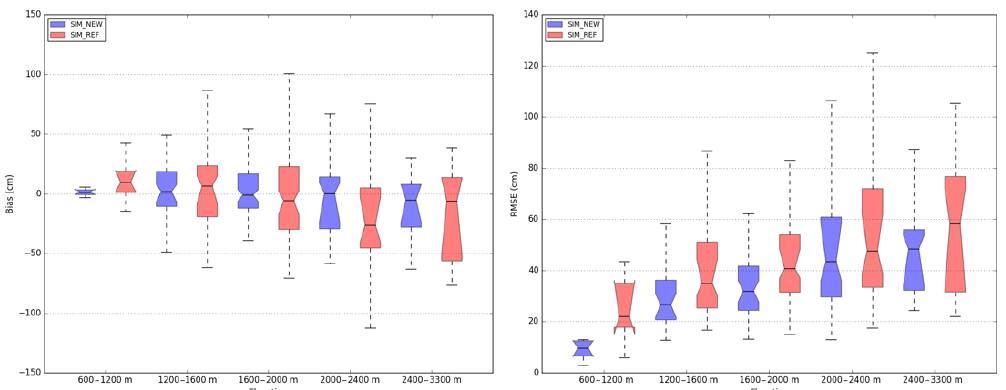
Figure 11. Bias and RMSE of daily total snow depth for SIM_NEW (blue) and SIM_REF (red) simulations as a function of elevation. The scores are computed for 185 stations over the period 1984–2016 for months between October and June. The boxes represent the interquartile interval, the whiskers the 10th and 90th percentiles, and the notch the 90% confidence interval of the median estimated by a bootstrap sampling technique among the available stations.